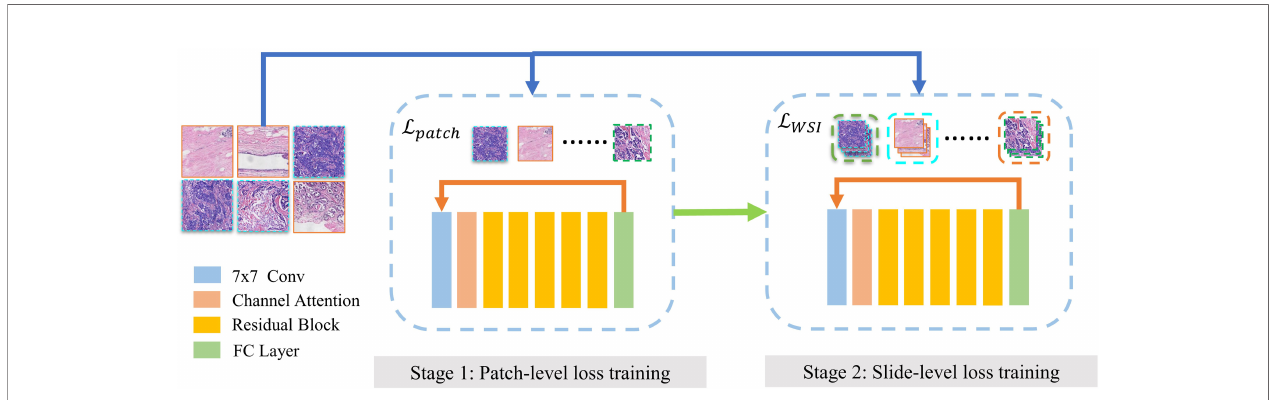
FIGURE 3 | Two-stage training of MIL model. Finetuning of MOL model contains two stages. (1) Model is trained on discriminative patches using patch-level loss. (2) Model is trained for slide-level subtyping using slice-level loss.